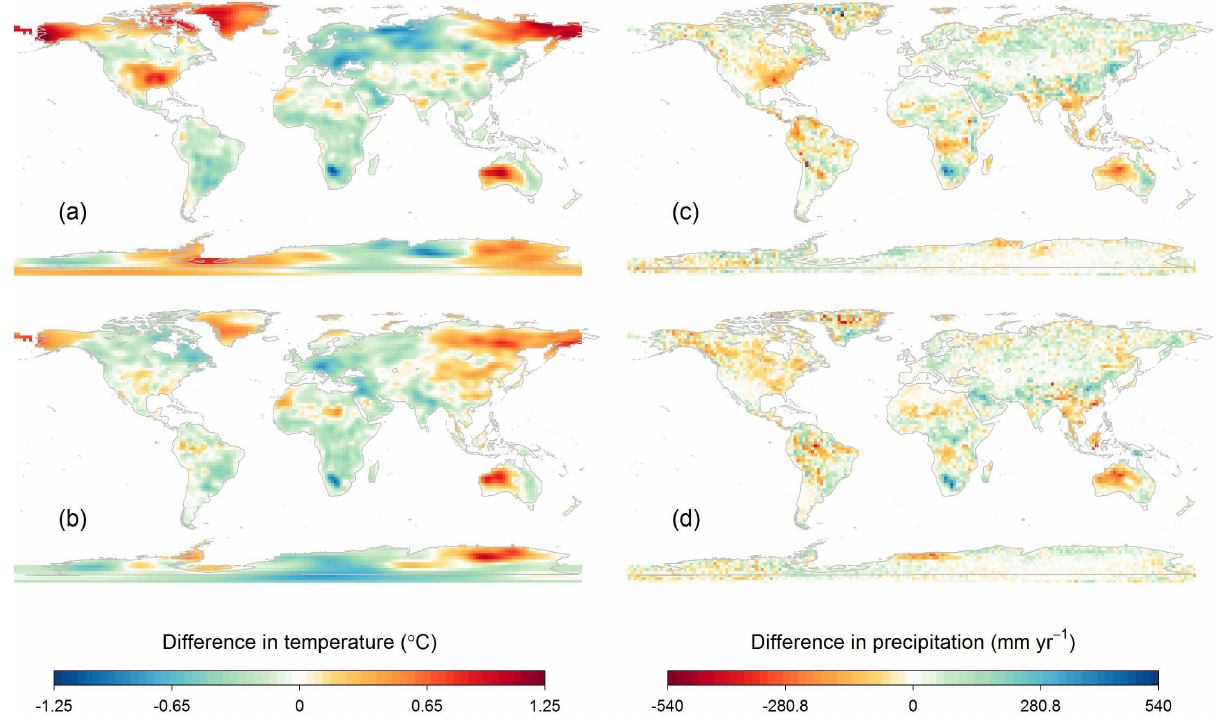
Fig. 6. Difference in mean annual temperature ( ◦ C) and annual precipitation (mmyr − 1 ). Observed traits simulation minus default simulation for (a) temperature and (c) precipitation, and variable traits simulation minus default simulation for (b) temperature and (d)